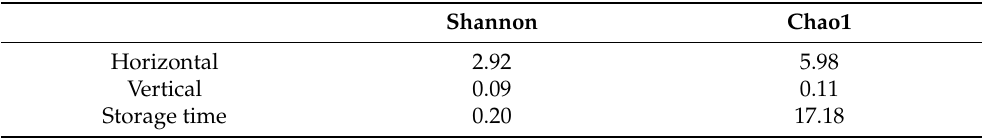
Table 2. Effect of granary orientation, vertical position and storage time on the variance of fungi Shannon diversity index and Chao1 abundance